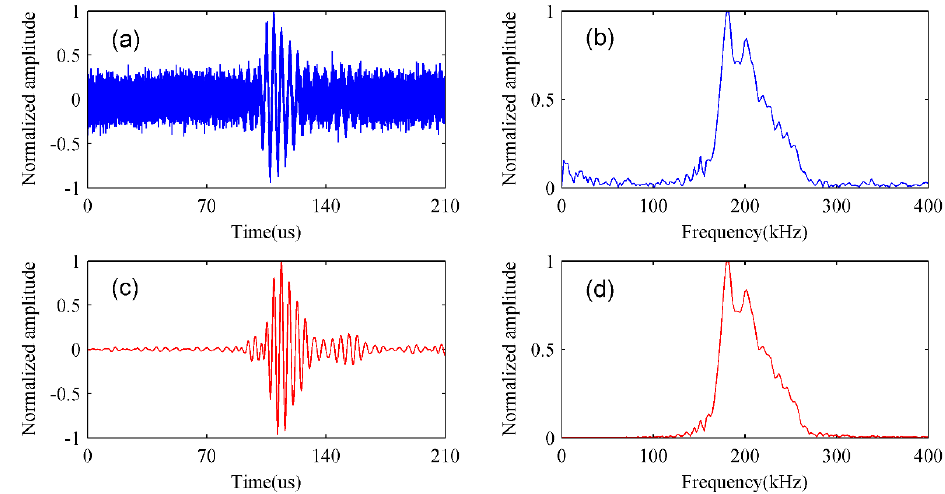
Figure 17. Band ‐ pass filtering of an experimental signal. ( a ) Original signal; ( b ) spectrum of the original signal; ( c ) filtered signal; ( d ) spectrum of the filtered signal. Appl. Sci. 2018 , 8 , x